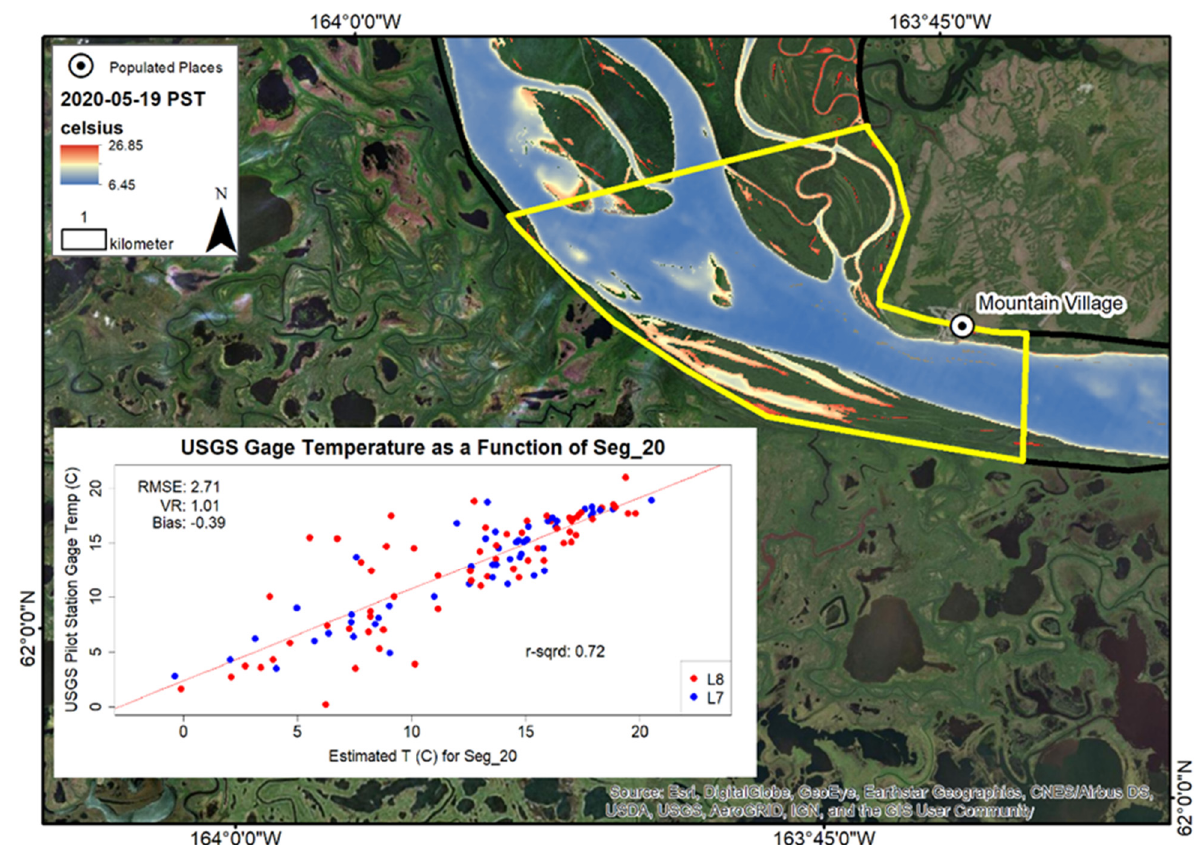
Figure A18. Segment 20 is characterized by the division of the Yukon into two large channels and a number of sloughs. This is a result of the river losing contact with the Adreafsky Mountains. The community of Mountain Village falls within this segment. Multiple islands occur within this segment and produce warm water signatures. At lower stages, the size and number of exposed islands increases. Recently abandoned river channels also produce warm water signatures when river height is sufficient to inundate these areas as is depicted above. The pST coverage is 100% with no NoData gaps; however, correlation between water temperature datasets is lower in this segment (RMSE = 2.71 °C, r 2 = 0.723) compared to most upstream segments.